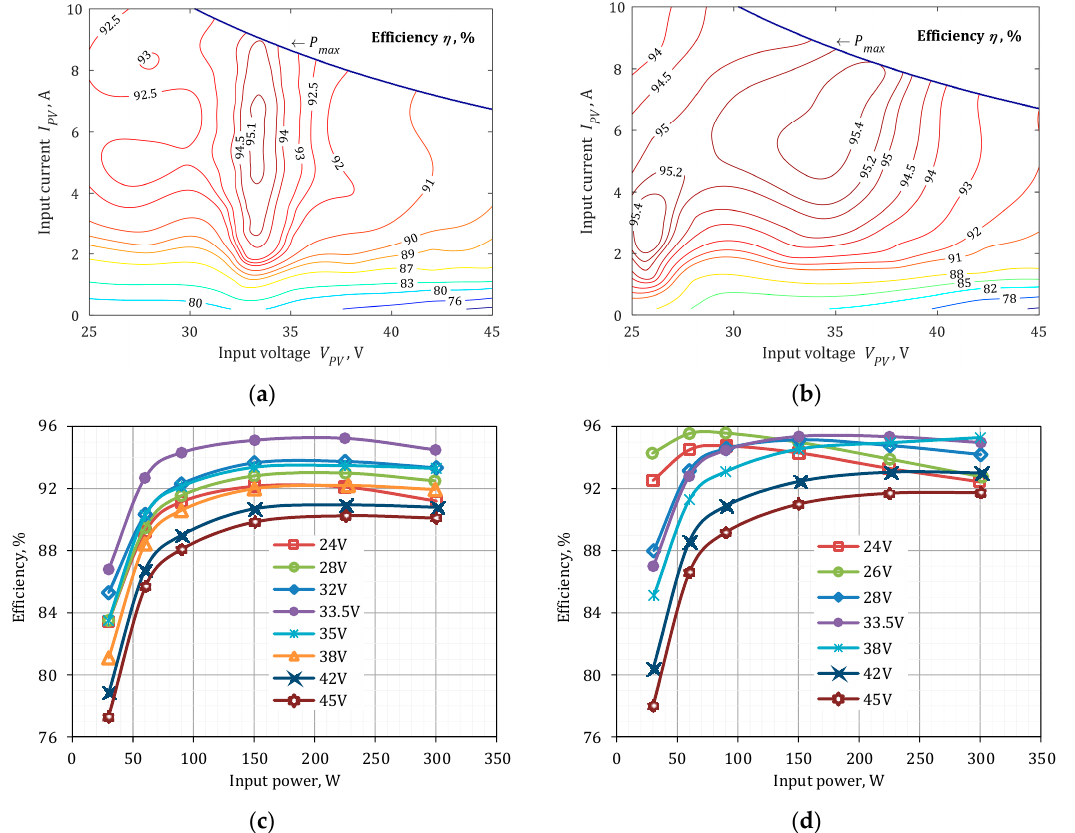
Figure 6. Interpolation results of the experimental efficiencies obtained for the prototype (Figure 3) operating with fixed ( a ) and variable ( b ) dc-link voltage control, which were derived based on experimental measurements obtained using fixed ( c ) and variable ( d ) dc-link voltage control.